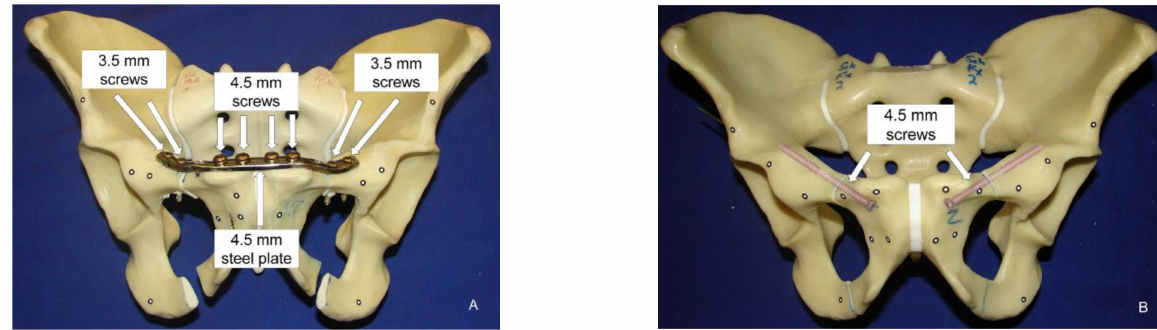
Figure 1. Anterior view of two specimens prepared for biomechanical testing with simulated straddle fracture of the pelvis, fixed with either an anterior plate (left, ( A ), group 1) or two bilateral retrograde transpubic screws (right, ( B ), group 2) and equipped with optical markers for motion tracking.